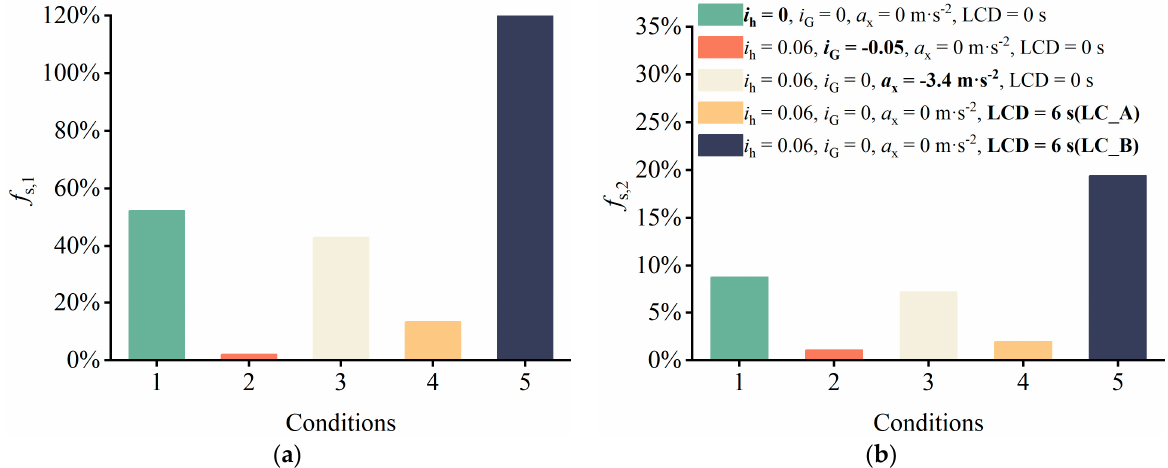
Figure 6. Effects of superelevation and longitudinal slope on the safety margin of the SUV. ( a ) Sideslip margin reduction rate. ( b ) Rollover margin reduction rate.